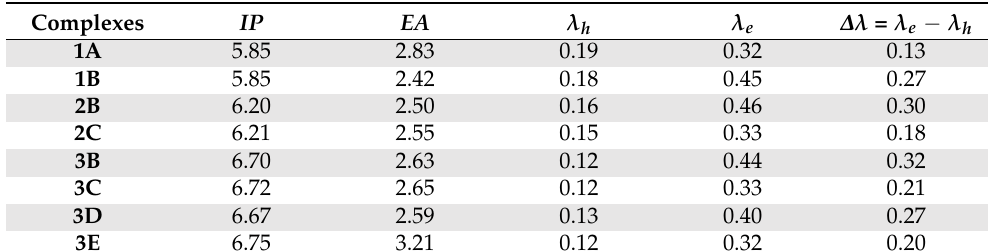
Table 5. The Ionization potential ( IP , eV), electron affinities ( EA , eV), hole/electron reorganization energy ( λ h / λ e , eV) and ∆λ